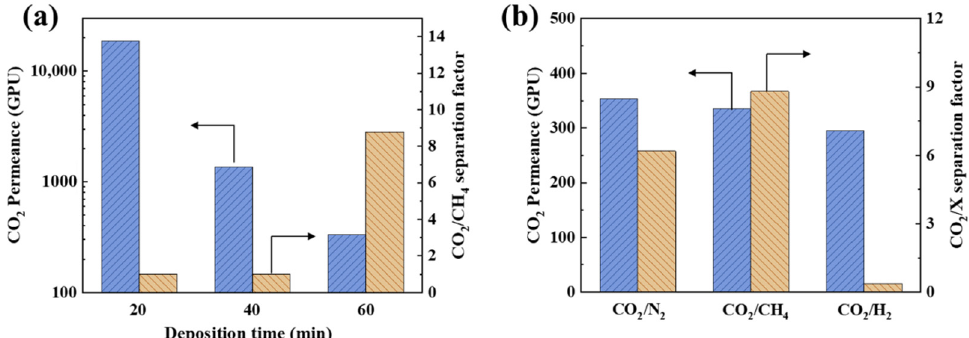
Figure 12. ( a ) Gas separation performance of ZIF-8/AAO membranes with different deposition times (deposition current: 0.65 mA/cm 2 ). ( b ) Gas separation performance of the ZIF-8/AAO membrane for different gas mixtures (deposition current: 0.65 mA/cm 2 , deposition time: 60 min).